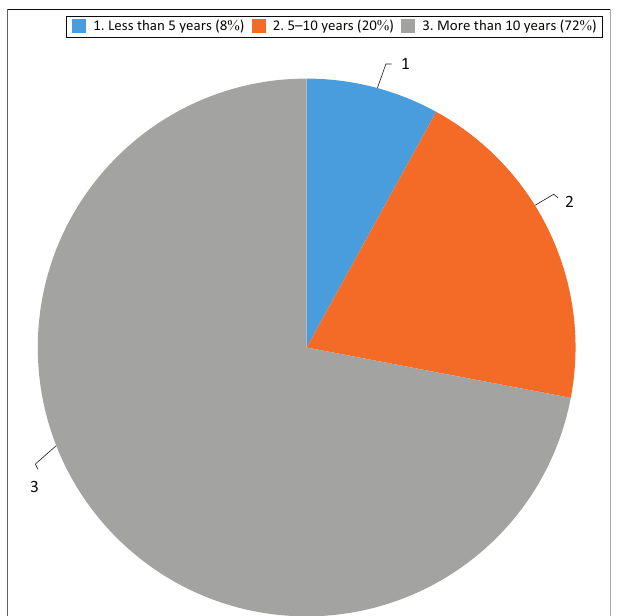
FIGURE 2: Respondents’ distribution according to clinical